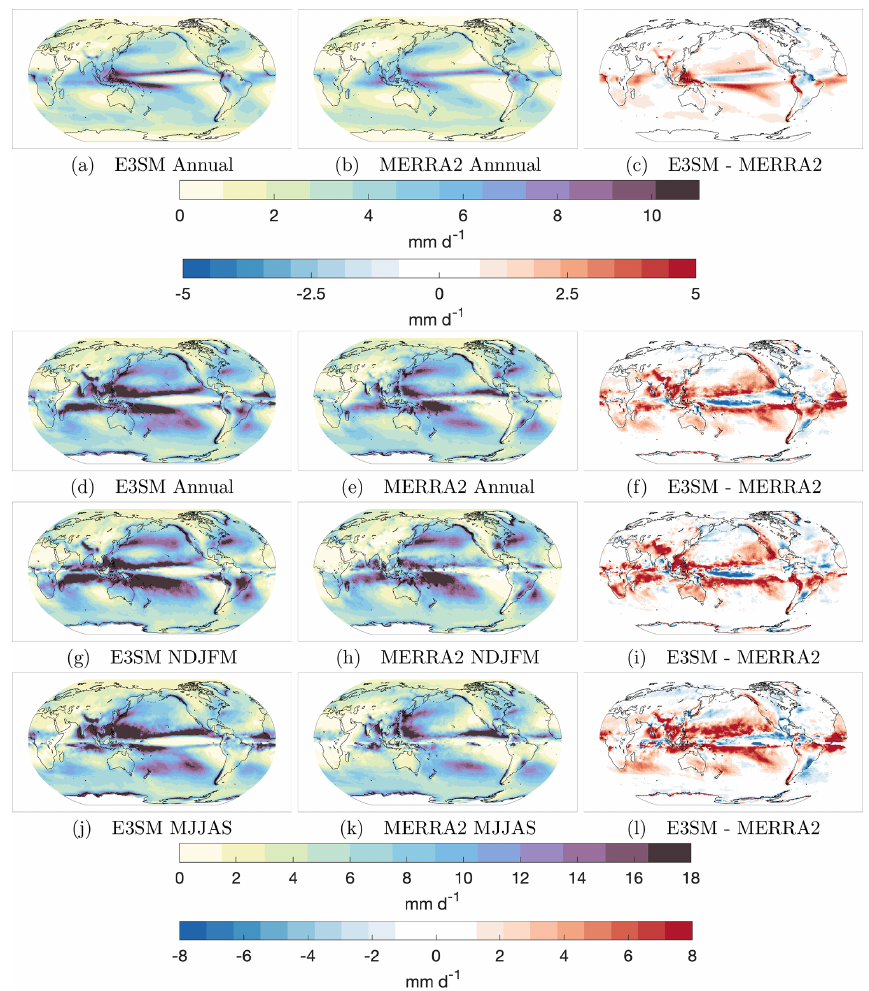
Figure 5. Top row shows annual precipitation in E3SM, MERRA2, and the difference. The next three rows are organized as in Fig. 1 but for AR precipitation instead of AR frequency. The color bar at the top (bottom) corresponds to the absolute (difference in) precipitation or AR